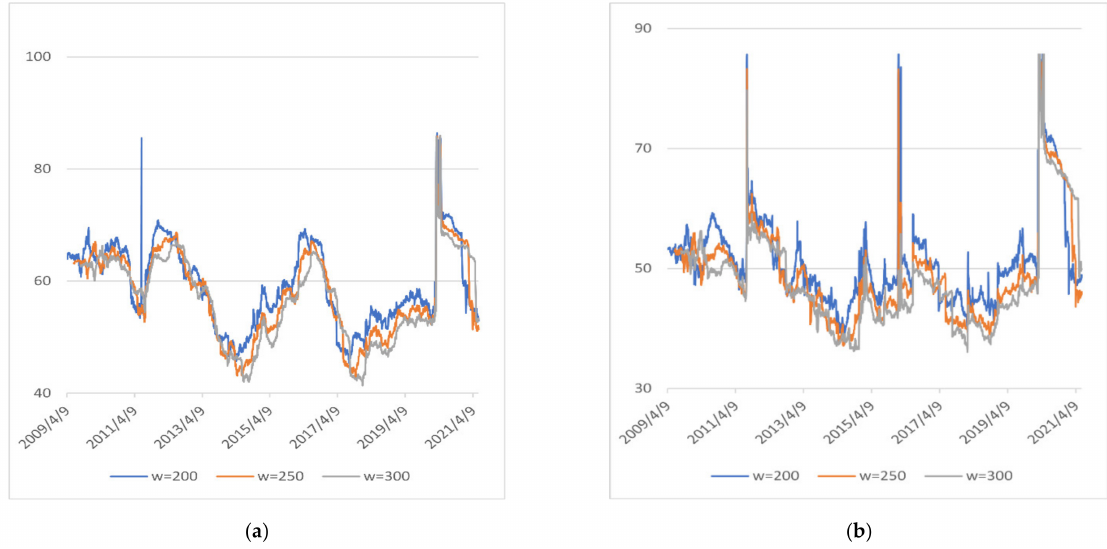
Figure 14. Dynamic total connectedness with window widths of 200, 250, 300 observations. ( a ) Price Return System. ( b ) Price Volatility